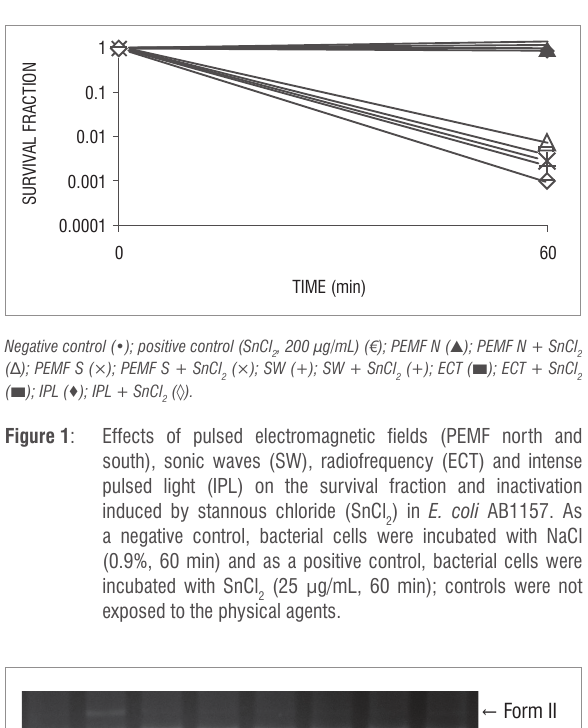
Figure 2: Photograph of agarose gel showing Form I (supercoiled DNA) and Form II (open circle DNA). Samples of pBSK plasmid were exposed to pulsed electromagnetic fields (PEMF north and south), sonic waves (SW), radiofrequency (ECT) and intense pulsed light (IPL). A 0.8% agarose gel electrophoresis (8 V/cm) was performed in tris-acetate-EDTA buffer. As a negative control, plasmids were incubated with NaCl (0.9%, 40 min) and as a positive control, plasmids were incubated with SnCl (200 µ g/mL, 40 min); controls were not 2 exposed to the physical agents.